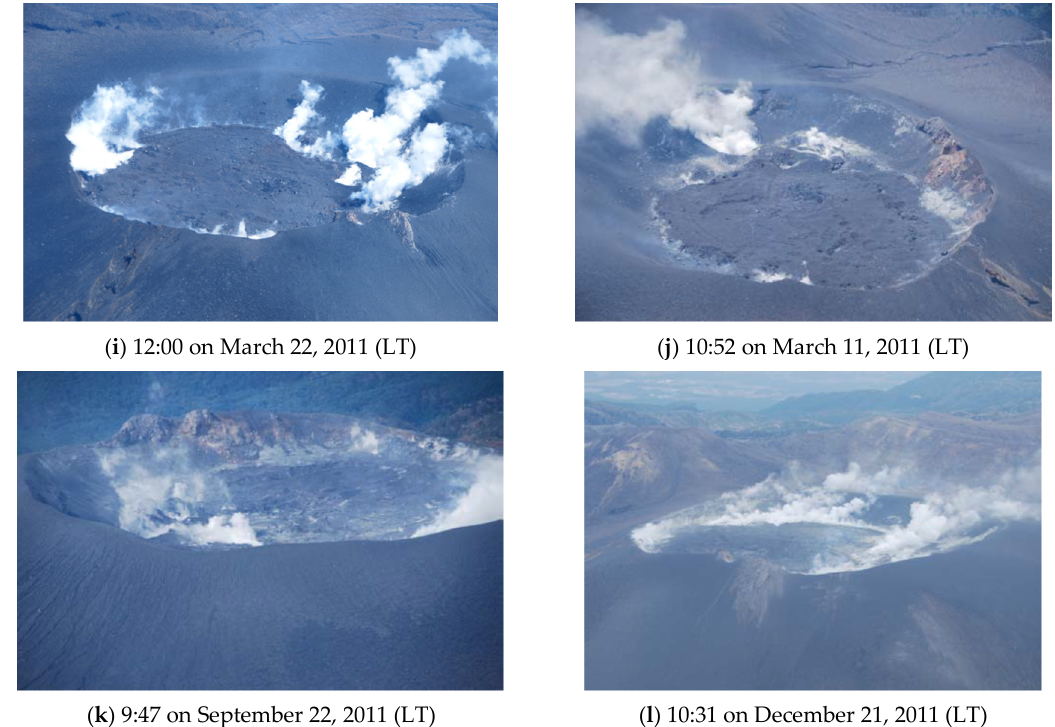
Figure A1. Aerial images of the summit crater of Shinmoedake from 21 January 2011 to 21 December 2011 (after JMA report [29]). On 19 January, there was a small eruption, probably due to a magmatophreatic explosion. The condition of the plume was unknown due to bad weather, but ashfall was confirmed from Shinmoedake in the southeast direction ( a ) 21 January: After magmatophreatic explosion, it was confirmed that the fumaroles, formed by the eruption on 27 May 2010, expanded, the ejecta was thickly accumulated in the crater and the cinder was scattered in the crater. Clear traces of ashfall were confirmed around the Shinmoedake crater and in the southeast direction from the crater. ( b ) The photo of the crater after the small eruption at 7:31 but before the magmatic explosion at 14:49 on 26 January. The plume was flowing to the southeast. The eruption at 07:31 shifted to the magmatic eruption around 14:49. Due to the magmatic eruption, small volcanic blocks (volcanic debris) with a diameter of 7–8 cm about 3 km southeast of Shinmoedake crater and a diameter of 4–6 cm about 7 km southeast of the crater were confirmed. This eruption continued until February 7. ( c ) The first explosive eruption occurred on 27 January. The plume was flowing to the southeast. ( d ) Accumulation of discharged lava in the crater on 31 January. It was about 500 m in diameter and the top of the lava dome reached near the crater edge; ( e ) Accumulation of discharged lava in the crater on 1 February. It was about 500 m in diameter and a part of the top of the lava dome was slightly lower than that of yesterday; ( f ) Accumulation of ejected lava in the crater on 2 February: Expanded to a diameter of 600 m. The top of the lava dome turned to be flat; ( g )–( l ) There was no particular change in the size and shape of the lava accumulated in the crater and the surrounding fumarole and the plume was rising from the north and east sides of the lava.